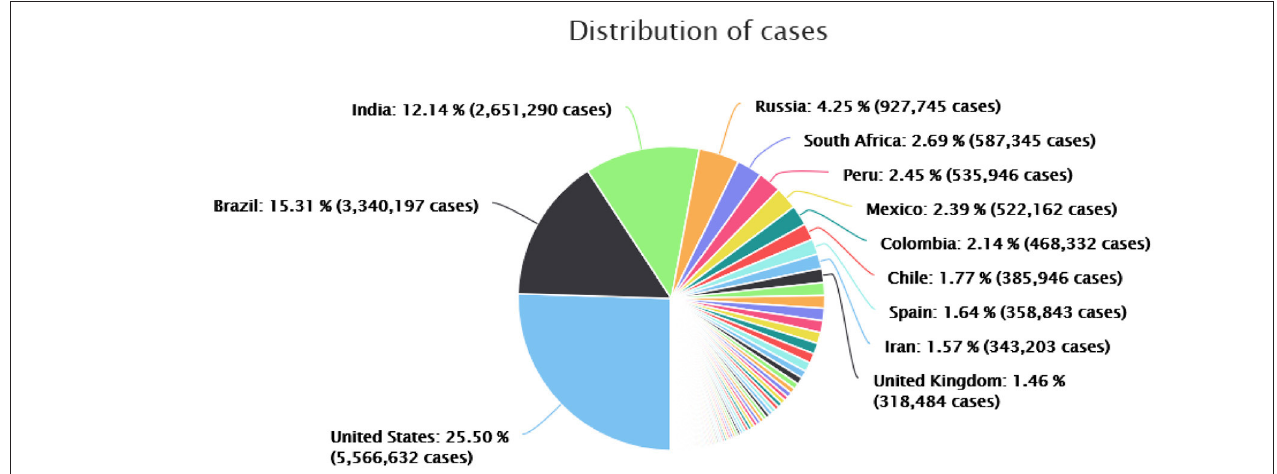
FIGURE 2 | COVID-19: analysis by countries with highest global cases (August 16, 2020). Source: data provided by World Health Organization related to coronavirus (COVID-19).